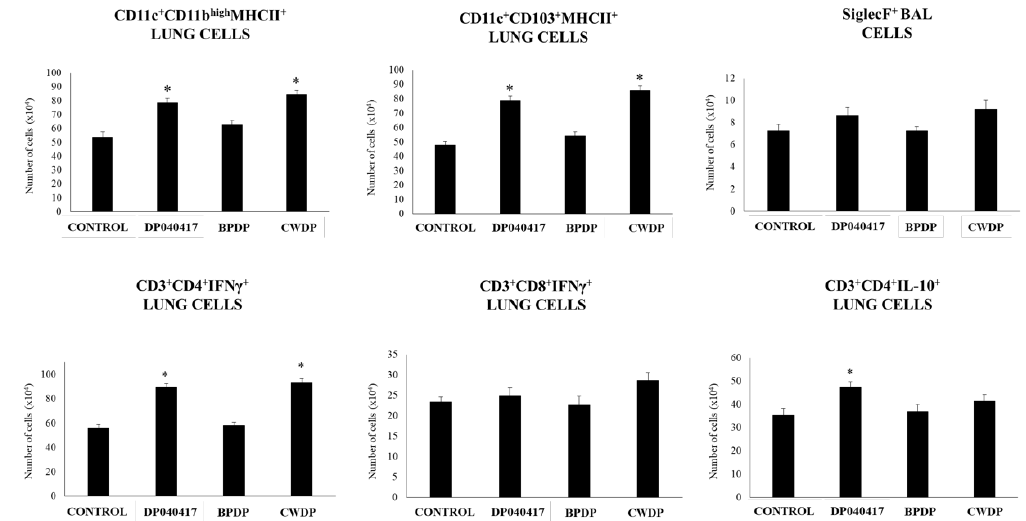
Figure 9. Effect of Dolosigranulum pigrum 040417 on respiratory immune cell populations after the nasal administration of the viral pathogen-associated molecular pattern poly(I:C). Infant mice were nasally primed with viable (DP), bacterium-like particles (BPDP) or cell wall (CWDP) from D. pigrum 040417 during five consecutive days and then challenged with three once-daily doses of poly(I:C). Non-treated infant mice challenged with poly(I:C) were used as controls. Two days after the last poly(I:C) administration, the numbers of lung T cells including CD3 + CD4 + IFN- γ + , CD3 + CD4 + IL-10 + , and CD3 + CD8 + IFN- γ + T lymphocytes, as well as antigen-presenting cells including MHC-II + CD11c + CD11b low CD103 + and MHC-II + CD11c + CD11b high CD103 - dendritic cells, and CD45 + MHC-II - CD11c + SiglecF + alveolar macrophages were determined by flow cytometry. Experiments were performed with 5 – 6 mice per group. The results represent data from three independent experiments. Significantly different when compared to control * p < 0.05 or ** p < 0.01.